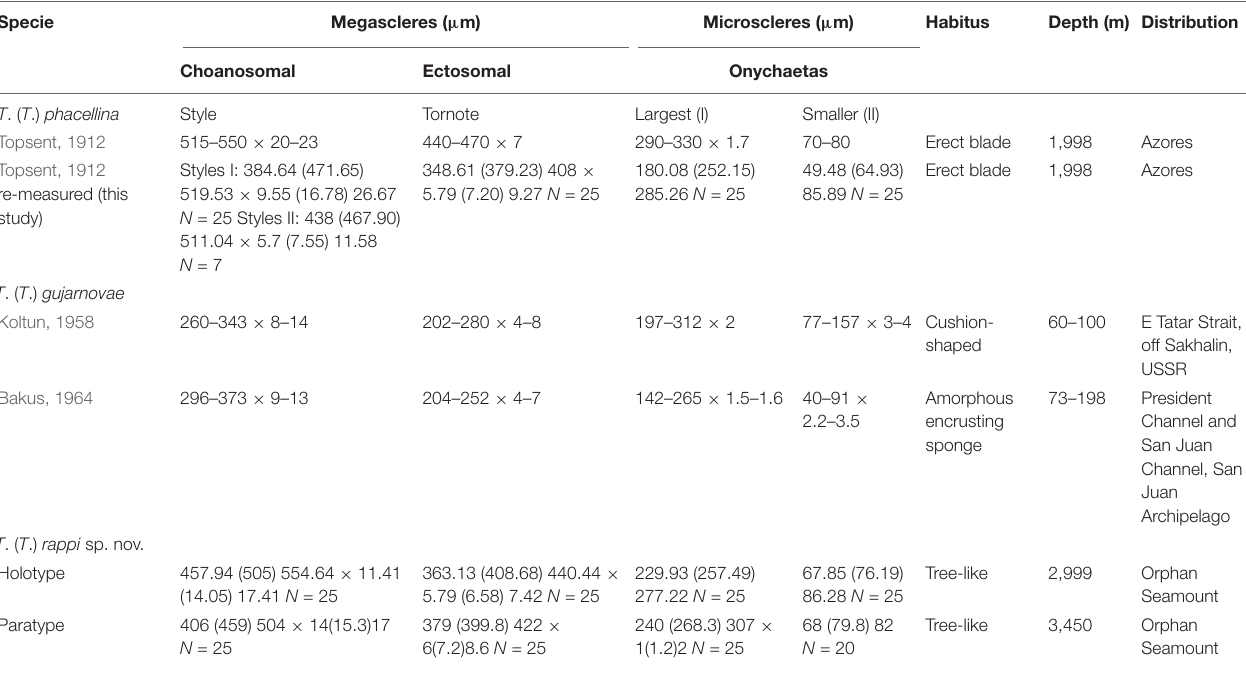
TABLE 1 | Spicule characteristics of Tedania ( Tedaniopsis ) species from the northern